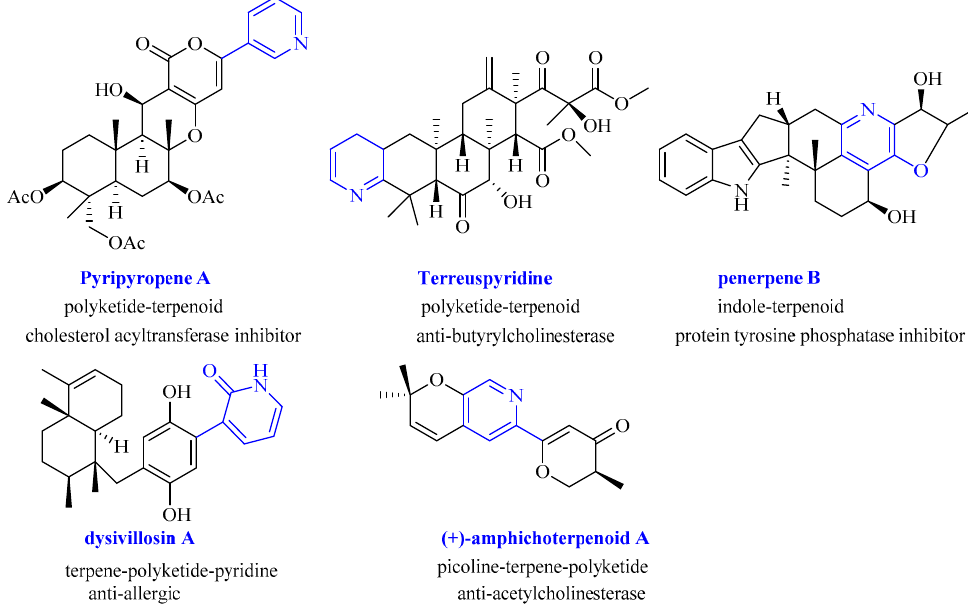
Figure 1. Chemical structure and bioactivities of the representative meroterpenoids with pyridine unit.